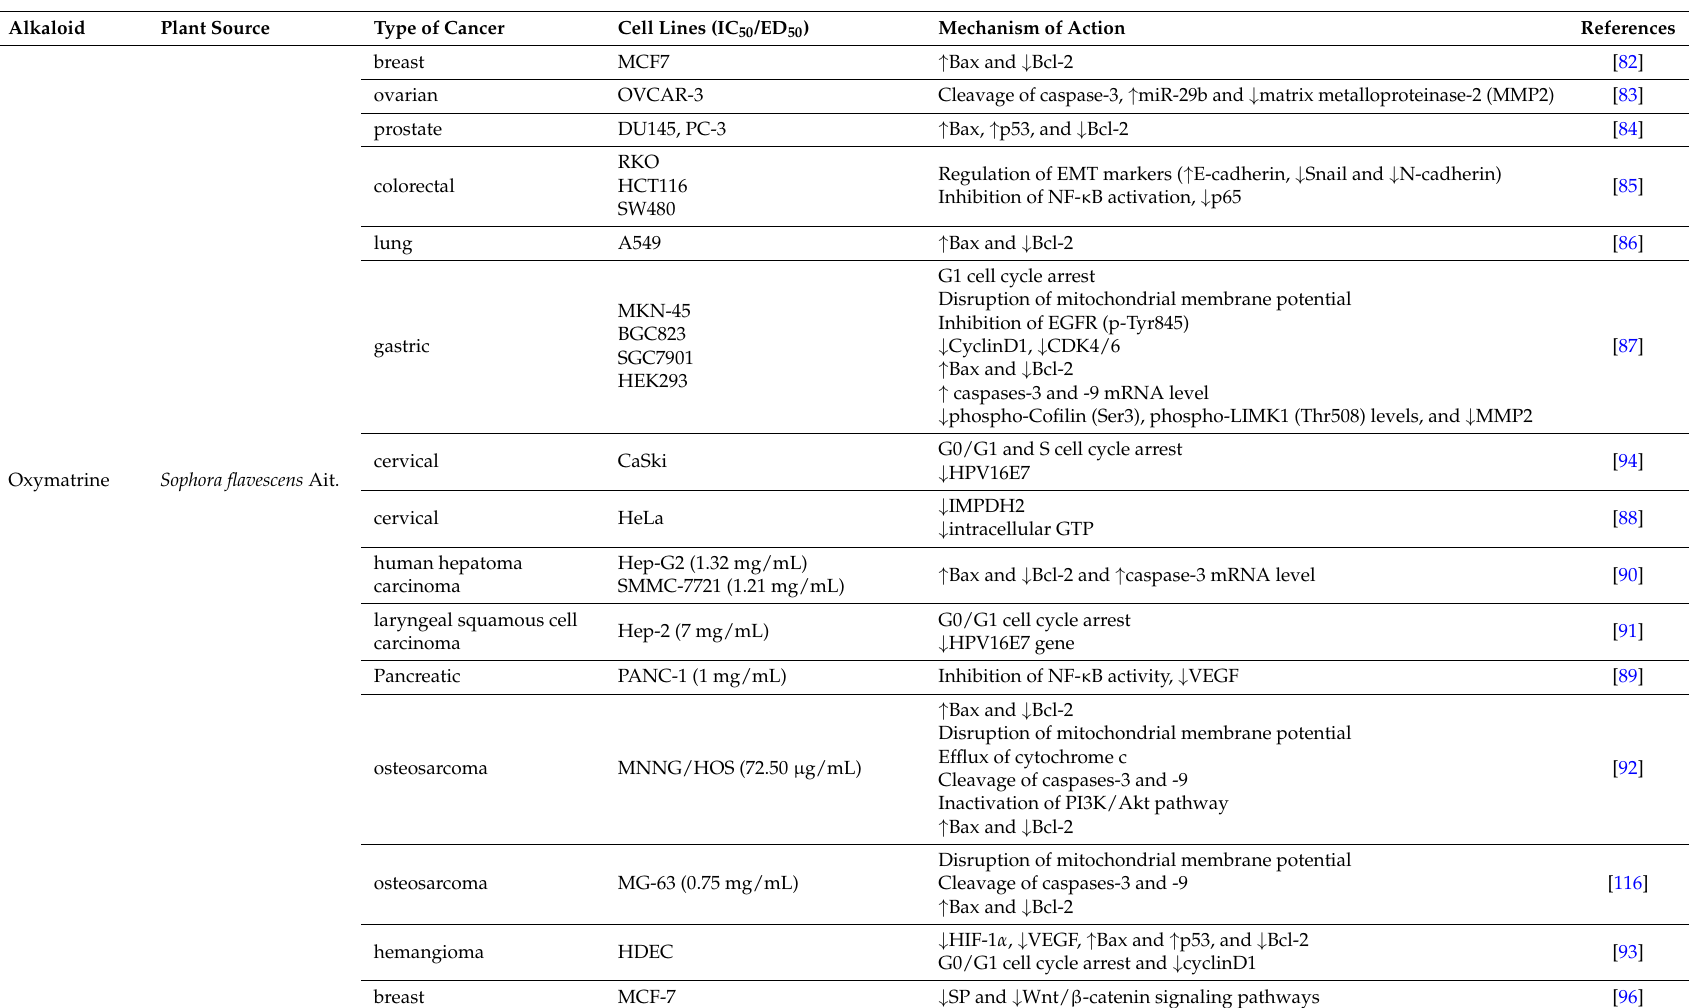
Table 4. Activities and mechanisms of action of most researched emerging plant-derived alkaloids on cancer cell